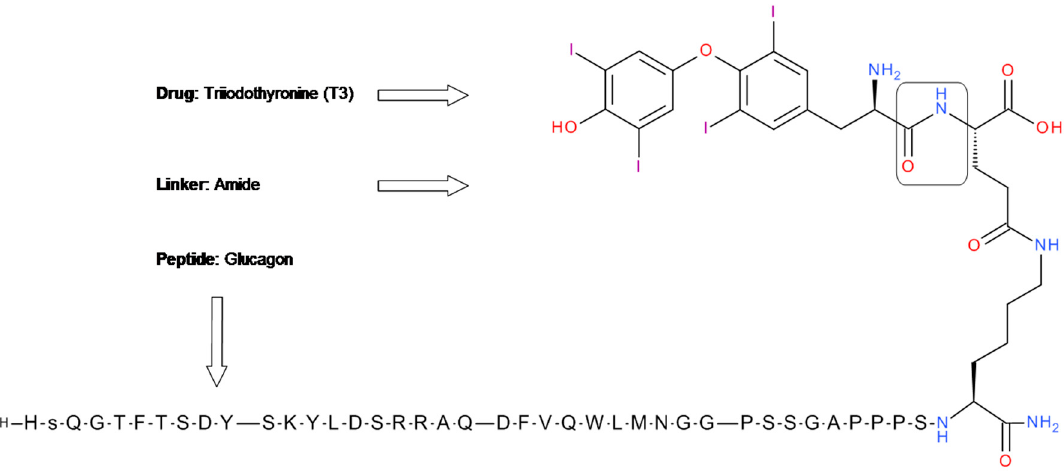
Figure 6. Chemical structure of glucagon-T3 conjugate.